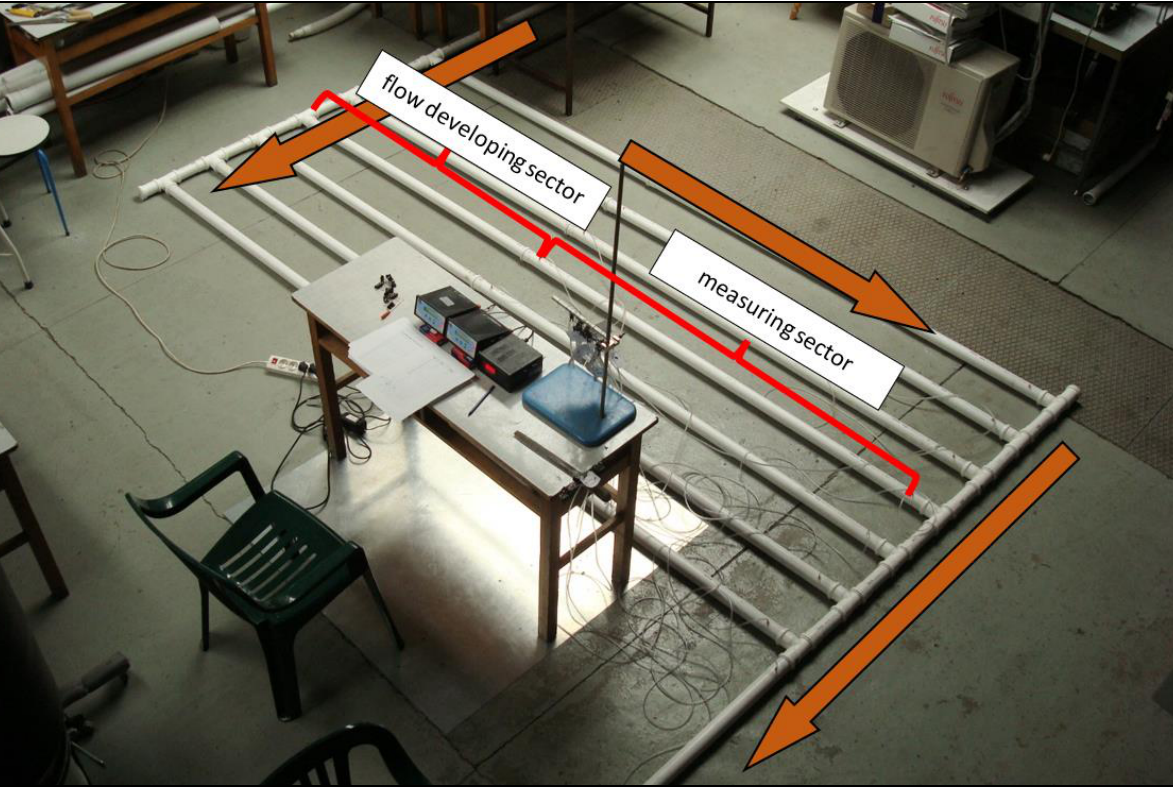
Figure 3. Photo of the experimental setup in the laboratory.